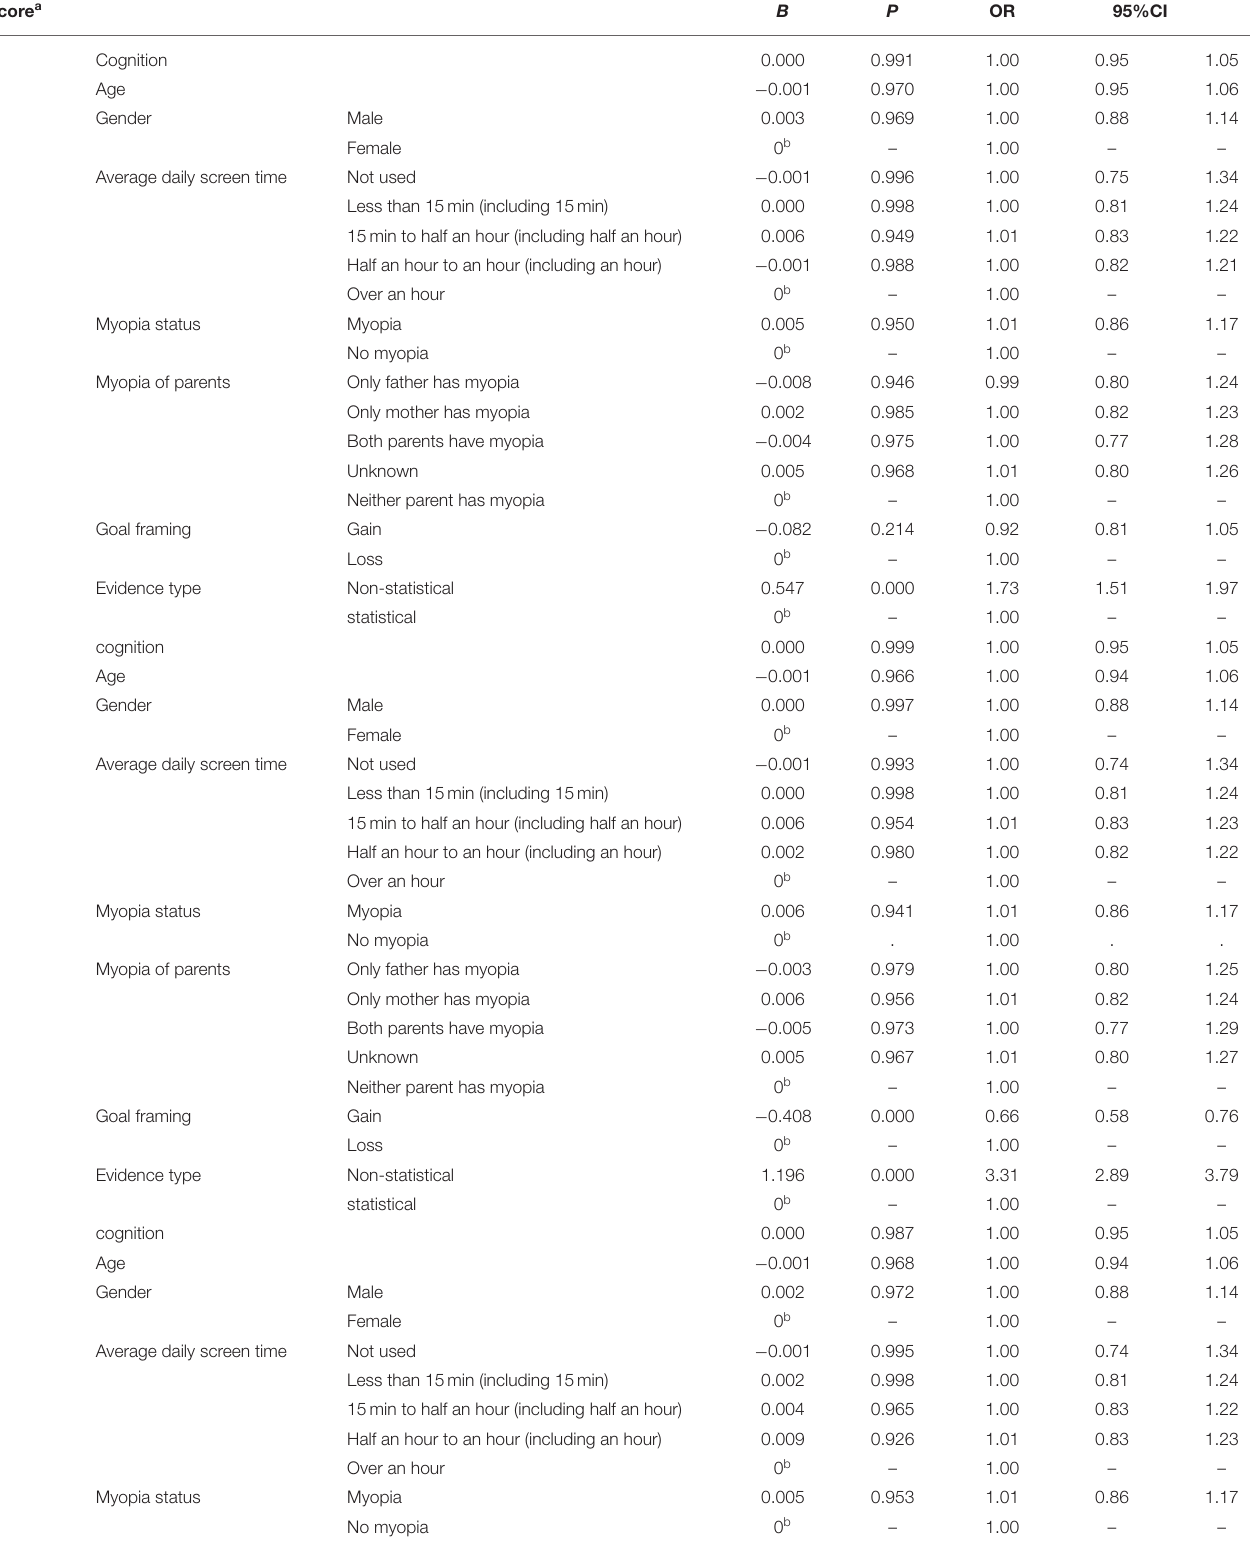
TABLE 5 | Multinomial logistic regression analysis for factors affecting persuasive effect. Score